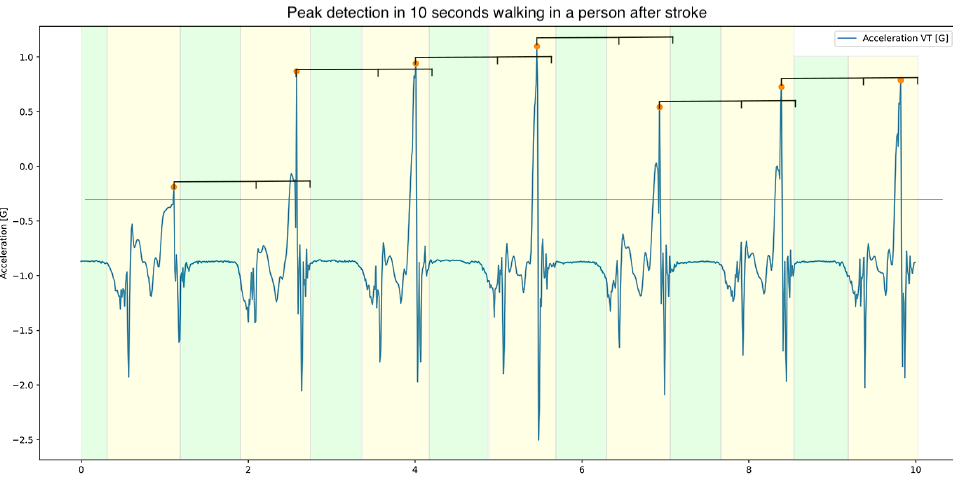
Figure 2. Visualisation of the custom-made stride-detection algorithm during 10 s of walking by a person after stroke. The vertical acceleration is depicted as a blue line. First, the strides were detected using a peak-detection algorithm; the threshold is depicted as the orange line and the search window is depicted as the black line above the peaks. The found peaks are marked with an orange circle. Then, a false-negative peak detection was applied, and the stance phases were identified as the stationary periods between peaks (green planes). Lastly, a false-positive peak detection was applied in case no stationary period between peaks could be identified. The signal that was not marked as part of the stance phase was considered to be the swing phase (yellow